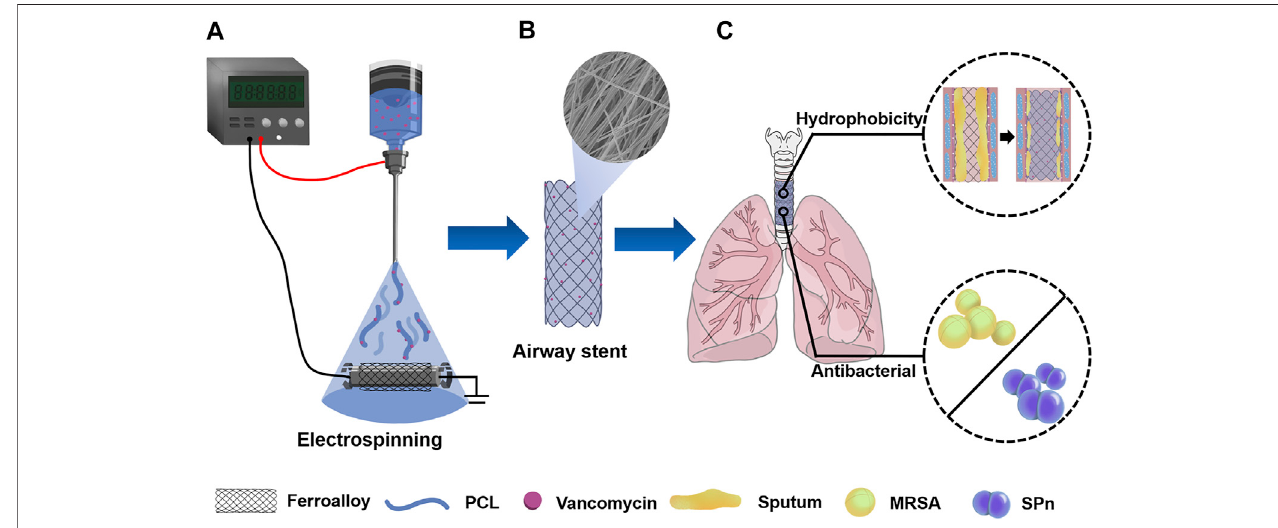
FIGURE1|(A) PCL/VA fi lm – coated metallic stent(PVNF-n)waspreparedbytheelectrospinning technique. (B) PVNF-nsamplesexhibited aninterwovennetwork structure. (C) PVNF-n was transplanted into the trachea to restrain tracheal stenosis, mainly by inhibiting the retention of sputum and the growth of airway bacteria including methicillin-resistant Staphylococcus aureus (MRSA) and Streptococcus pneumoniae (SPn).